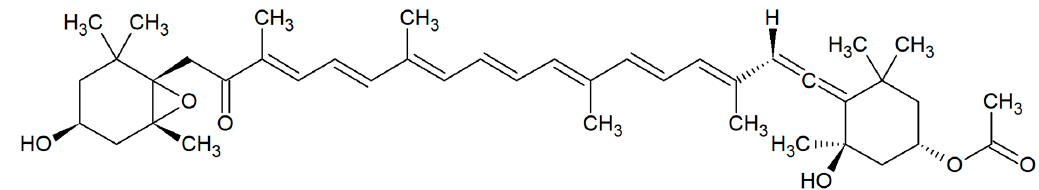
Figure 1. Chemical structure of fucoxanthin.